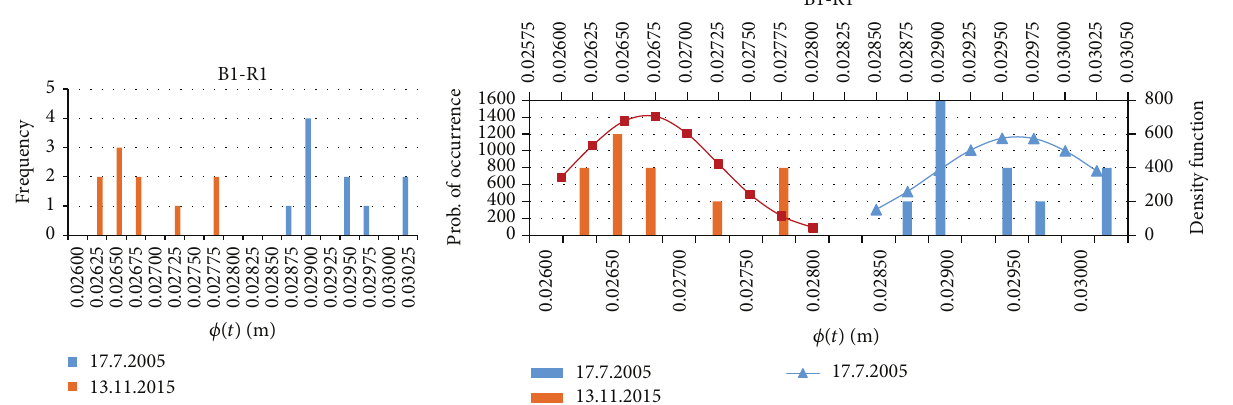
Figure 10: Comparison of diameter 𝜙(𝑡) change of B1-R1 in time 𝑡 .